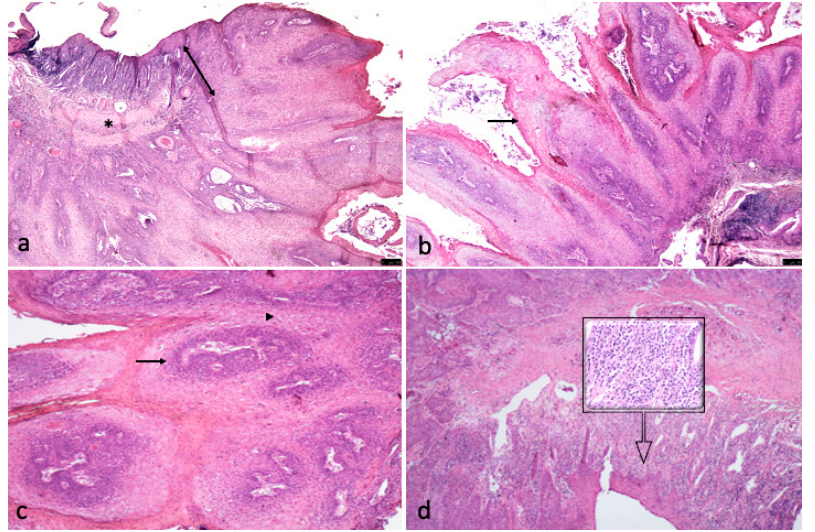
Figure 3. ( a ) Conjunctival epithelium (double-edged arrow) invaginating downward the underlying submucosa (asterisk, HE 5 × ); to form ( b ) numerous long papillary projections of hyperplastic stratified squamous epithelium (arrow, HE 5 × ); ( c ) cross section of papillary fronds showing a fibrovascular core surrounded by hyperplastic stratified squamous epithelium with conserved normal architecture (arrow, HE 10 × ). Many koilocytes were identifiable (arrowhead) ( d ) a mixed chronic inflammatory cell infiltrate, mainly composed by lymphocytes and plasma cells, was interposed between the boundaries of the lesion and the surface epithelium (HE 2.5 × . Inset. 40 × ). In focal areas of the mass, the growth appeared disorganized, with loss of polarity of the keratinocytes and loss of normal keratinocyte maturation invading and infiltrating the submucosal tissues. This neoplastic growth was often arranged in trabecular, papillar, or nest patterns with cells showing mild to moderate pleomorphism, multiple nucleoli, dys- keratinization, increased mitotic count (4 up to 9/high power field) and atypical mitotic figures. Some “keratinic pearls” were identifiable as well as foci of neutrophilic inflam- mation surrounding the carcinomatous growth. Acantholytic cells, koilocytes and cells bearing intranuclear eosinophilic inclusions were also visible at the boundaries of the ma- lignant neoplastic growth or intermingled with the cancerous cells (Figure 4).